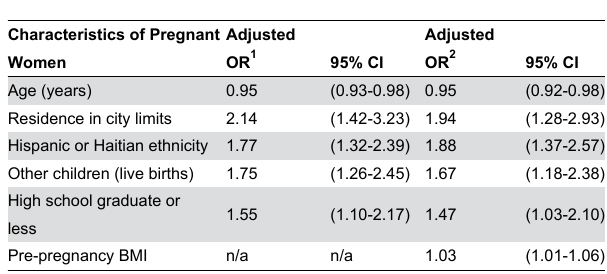
Table 2. Multivariable analyses of demographic and other characteristics associated with pandemic influenza illness during